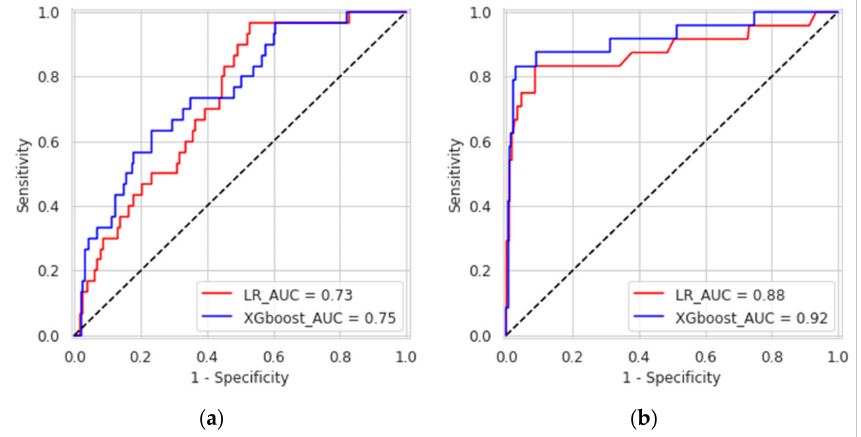
Figure 3. Receiver operating characteristic curves of the eXtreme gradient boosted trees and logistic regression for predicting causes of mitral valve repair failure and mitral valve regurgitation at one-month ( a ) and three years ( b